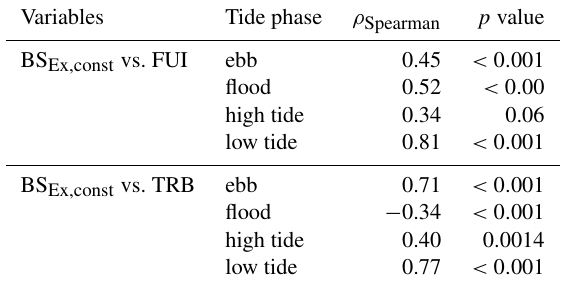
Table 2. Spearman rank correlation results of the backscatter data from the ADCP BS EX,const , the estimated Forel–Ule index FUI, and the turbidity TRB with separation into tidal